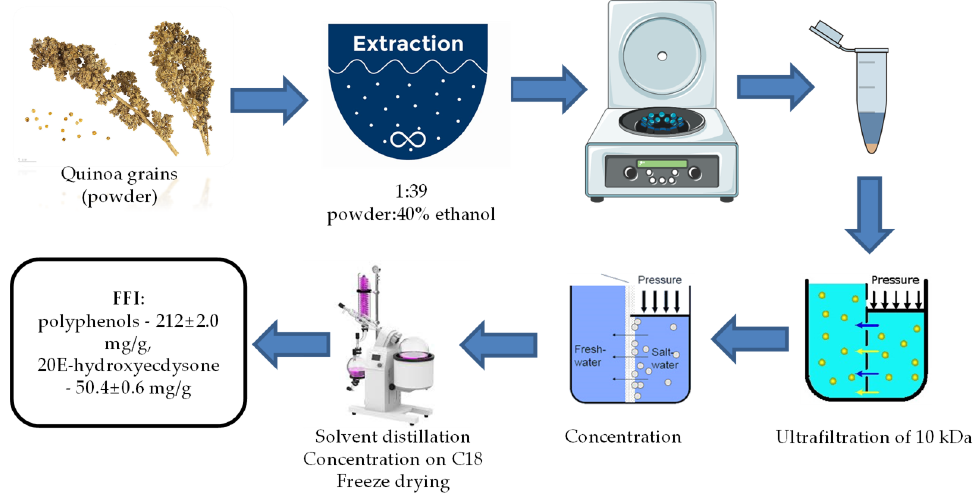
Figure 5. Flow chart of the FFI production from Chenopodium quinoa .